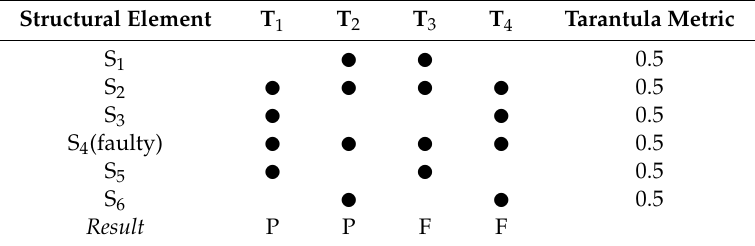
Table 1. Example of insu ffi cient fault localization